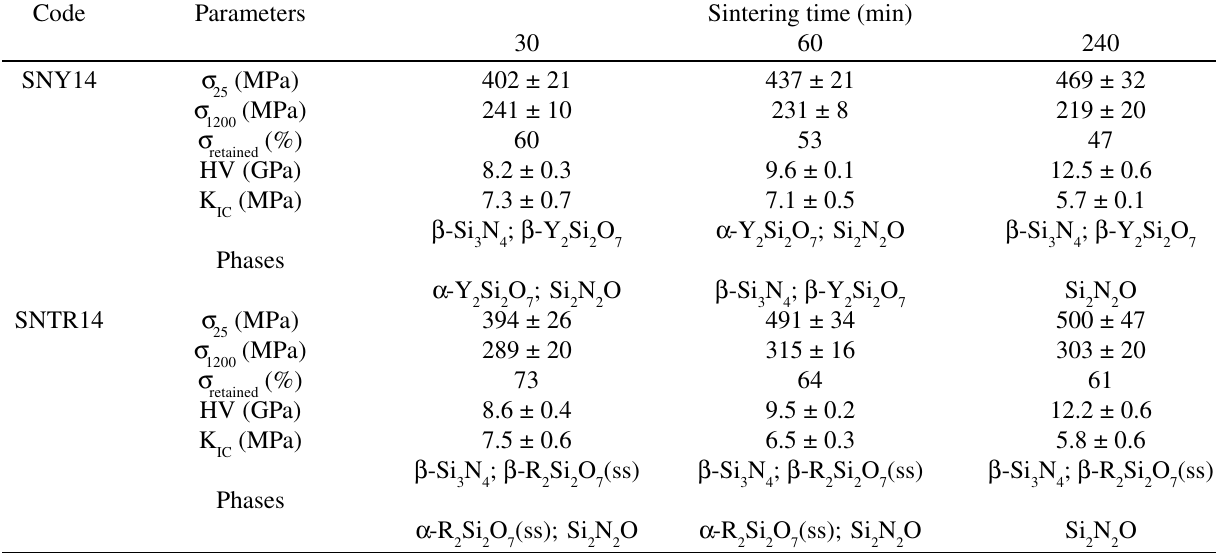
Table 4. Properties of the SNY14 and SNTR14 samples sintered at 1800 °C for 30, 60 and 240 min.